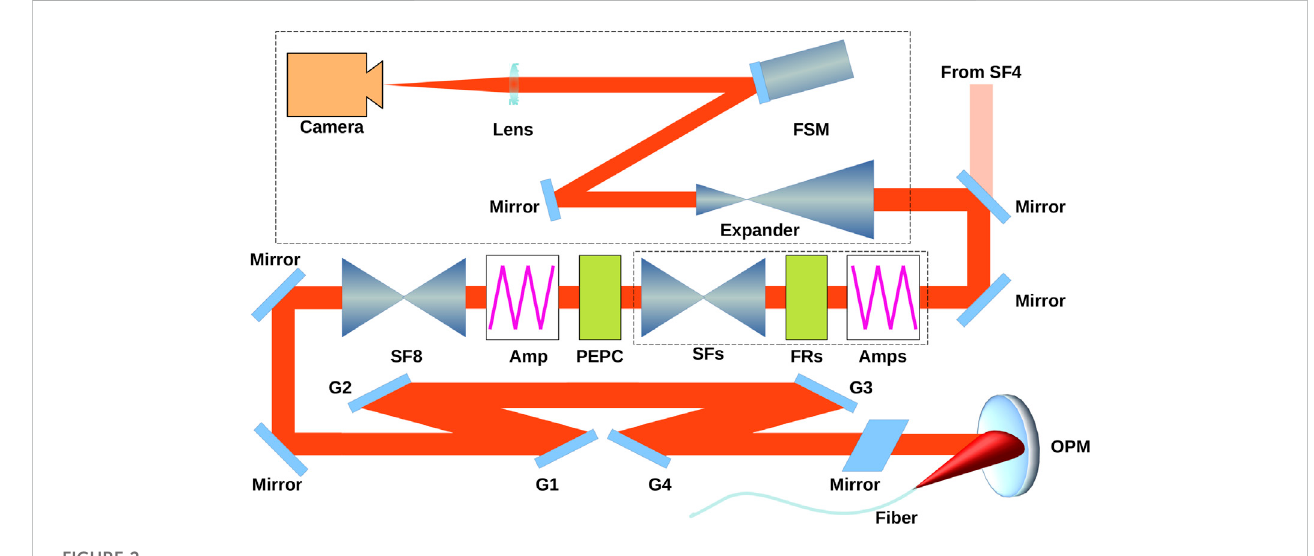
FIGURE 2 Test setup of SGII-UP-Petawatt – picosecond system.